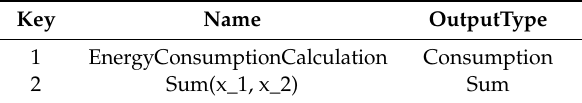
Table 2. Specification in the “BasicFunction” table.